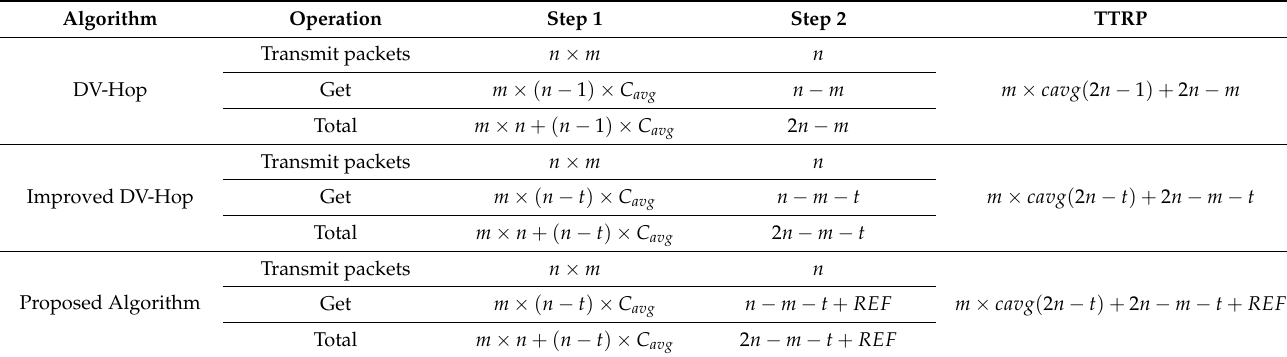
Table 11. Communication cost of different